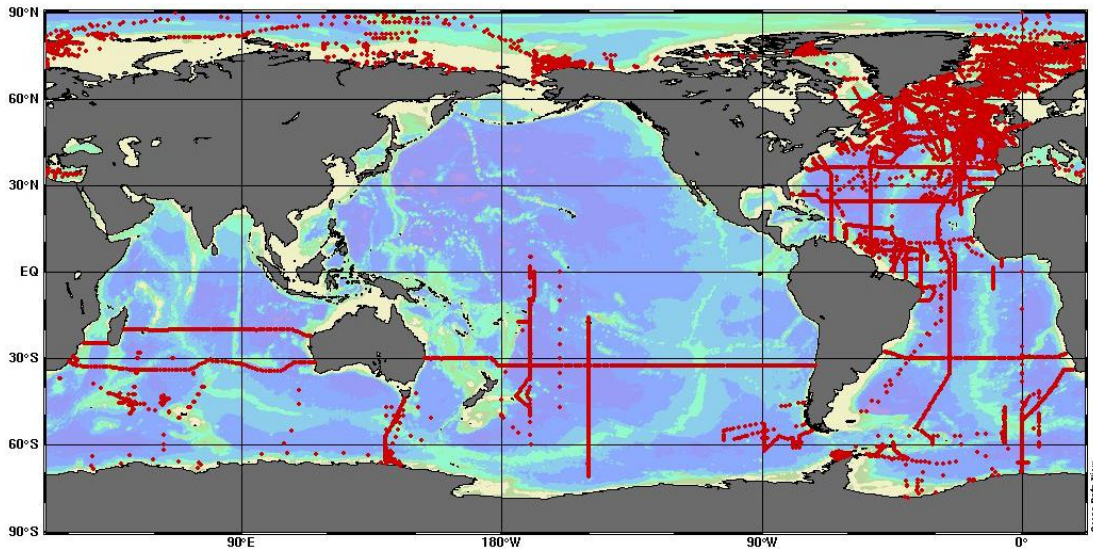
Figure 1. Station locations for cruises included in the three CARINA data products. The division between the Southern Ocean collection and the Atlantic collection was approximately 30 ◦ S and between the Atlantic and Arctic approximately 60 ◦ N (the Greenland-Scotland Ridge). Several cruises that cross one of the boundaries are included in both collections. Regional maps are available at http: // cdiac.esd.ornl.gov / oceans / CARINA / Carina inv.html and a cruise map and data file for each cruise at http: // cdiac.esd.ornl.gov / oceans / CARINA / Carina table.